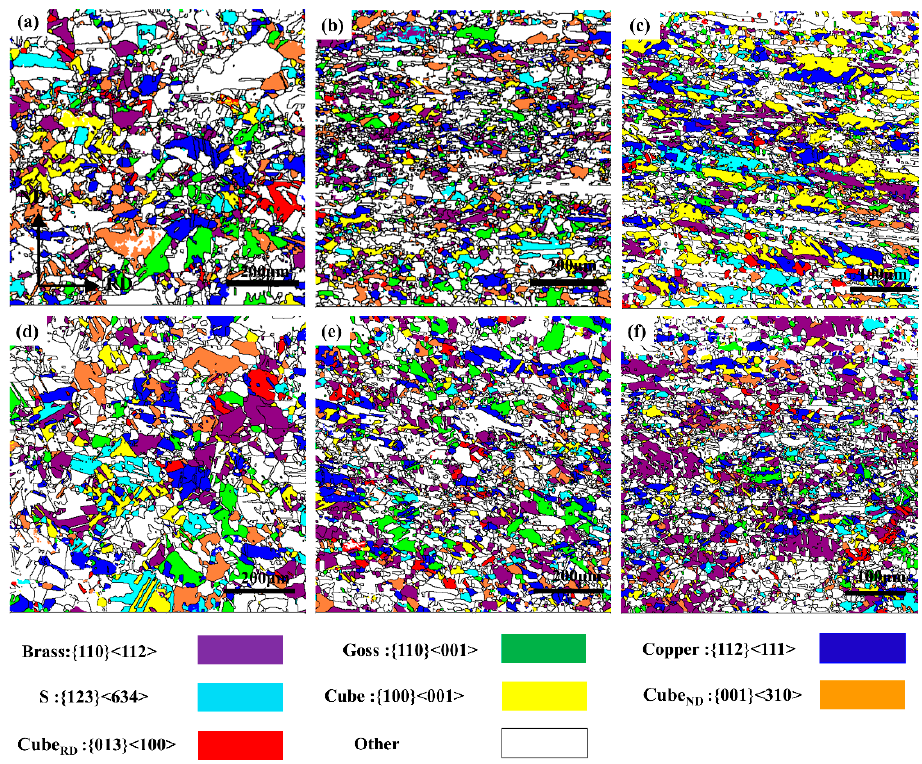
Figure 9. Orientation reconstruction of Cu-0.1Al alloy with different rolling methods after annealing at 300 °C for 60 min: ( a ) UR-54%; ( b ) UR-70%; ( c ) UR-90%; ( d ) CR-54%; ( e ) CR-70%; ( f ) CR-90%. Table 4. Grain size distribution of Cu-0.1Al alloy under different deformation methods after annealing at 300 °C for 60 min (%).